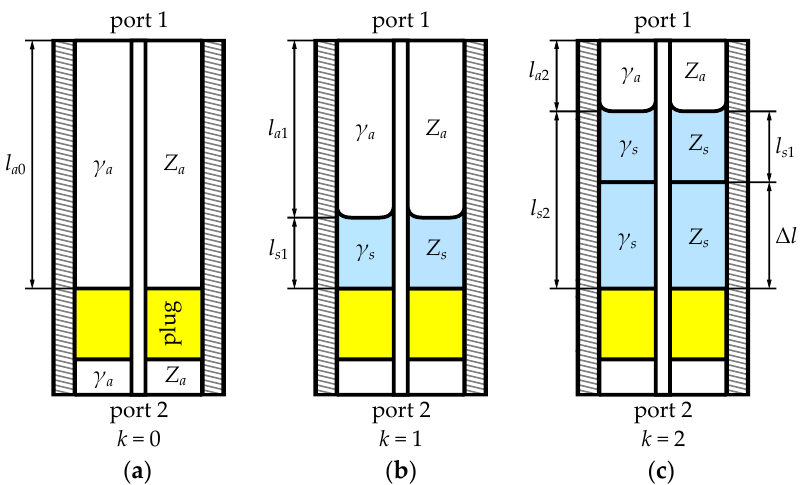
Figure 3. Sketch of the semi-open coaxial fixture in its three measurement states of liquid under test distorted by the meniscus: ( a ) the empty cell; ( b ) the initial volume of a liquid; ( c ) the final volume. List of symbols: l ak —the length of k -th airline section; l sk —the height of k -th sample; ∆ l —the height increment; Z a , Z s —characteristic impedances and γ a , γ s —propagation constants for the air and sample,